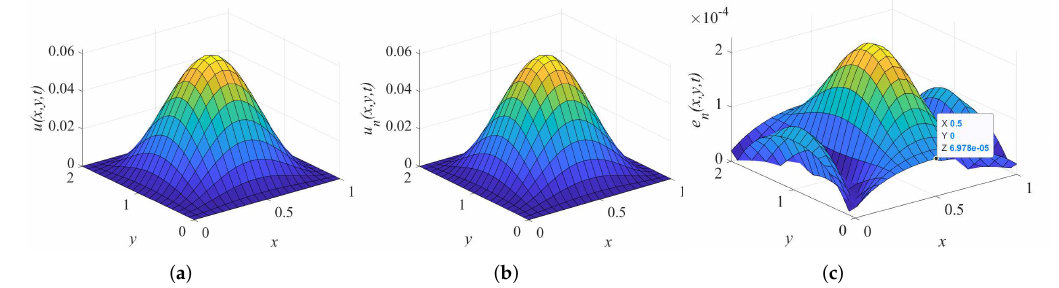
Figure 2. The mathematical example results for ( a ) analytical solution, ( b ) numerical solution and ( c ) absolute error at different points.